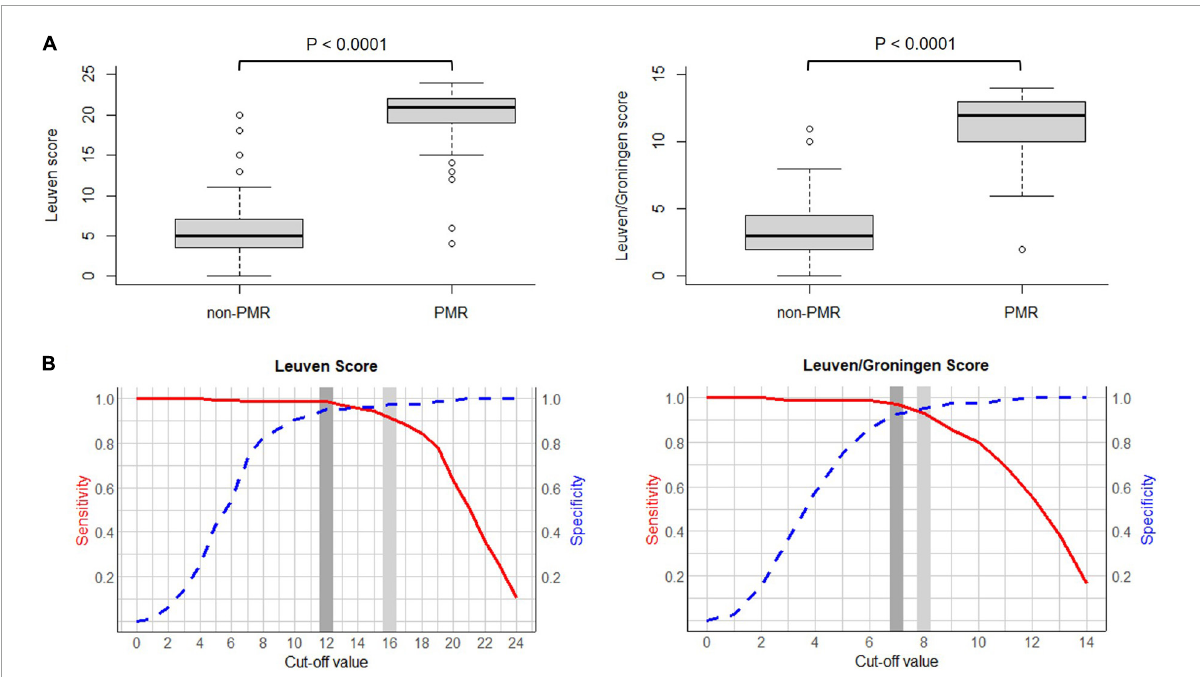
FIGURE2 (A) Boxplot of the Leuven score (left) and the Leuven/Groningen score (right) in PMR patients vs. non-PMR patients. (B) Curve of the sensitivity and specificity of the Leuven score (left) and the Leuven/Groningen score (right) with variable cut-offs. Legend: light gray, predetermined cut-off value; dark gray, optimal cut-off value determined by the Youden index. Abbreviations: PMR, polymyalgia